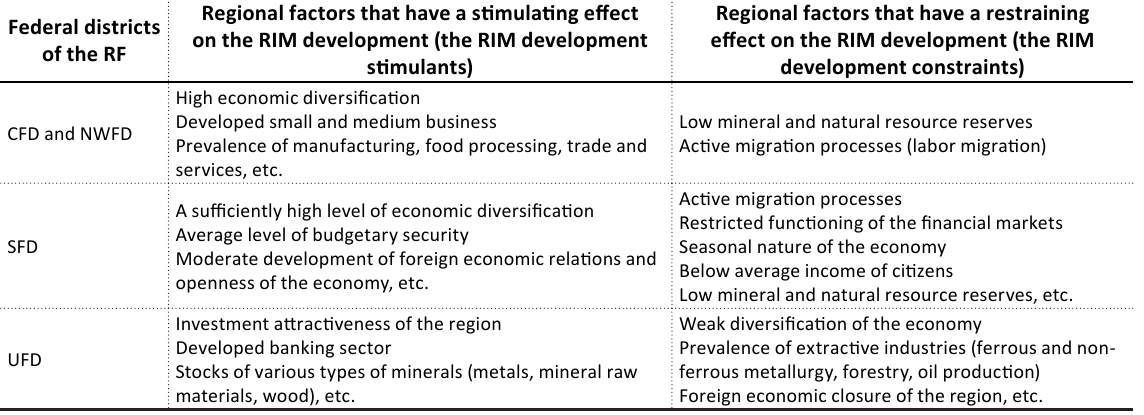
Table 3. Regional development factors affecting the RIM in the Central Federal District (CFD), the Northwest Federal District (NWFD), and the Southern Federal District (SFD) and Ural Federal district